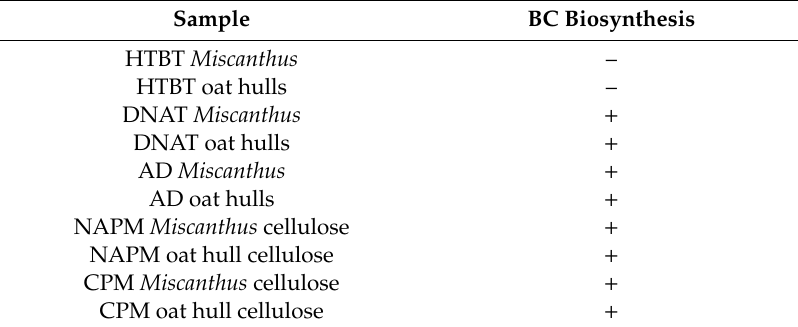
Table 4. Results of bacterial cellulose (BC) biosynthesis in enzymatic hydrolyzates produced from Miscanthus and oat-hull pretreatment